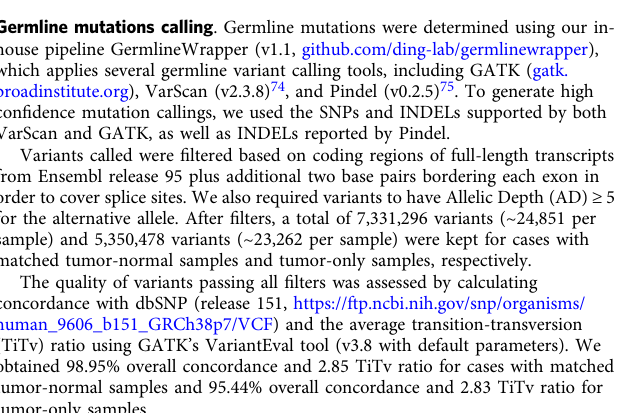
Fig. 7 NCI-MATCH trial related druggable genes and recurrent alterations. a Genomic alterations of 258 candidate PDX models, which satis fi ed the study arm speci fi cations across 23 cancer types, include the 25 target genes of non-silent mutations, 13 copy number alteration genes, and 3 fusion genes. b Distribution of 22 recurrent point mutations (> 1 PDX models) in the 10 druggable target genes with 9 drugs across 12 cancer types. The information in parentheses is a matched study arm. c Distribution of target arms per PDX model and positive signal arms in PDX samples. The left pie chart presents the distribution of PDX models in single-arm and multiple-arm (>1 arms). The right chart shows the percentage of PDX models between wild type and arm- event. d , e Target drugs and target gene alterations that are associated with gene expression ( N , number of independent PDX models; n , number of independent PDX samples). d The point mutations of target arms that relate to upregulation of gene expression in cancer. e The ampli fi cation-related target arms match with upregulation of gene expression in different cancer types ( n , number of PDX samples). And gene expressions are signi fi cantly different (absolute value of log2-fold-change> 0.585 and p < 0.05) between wild-type (WT) and ampli fi cation. In d and e data are presented as box